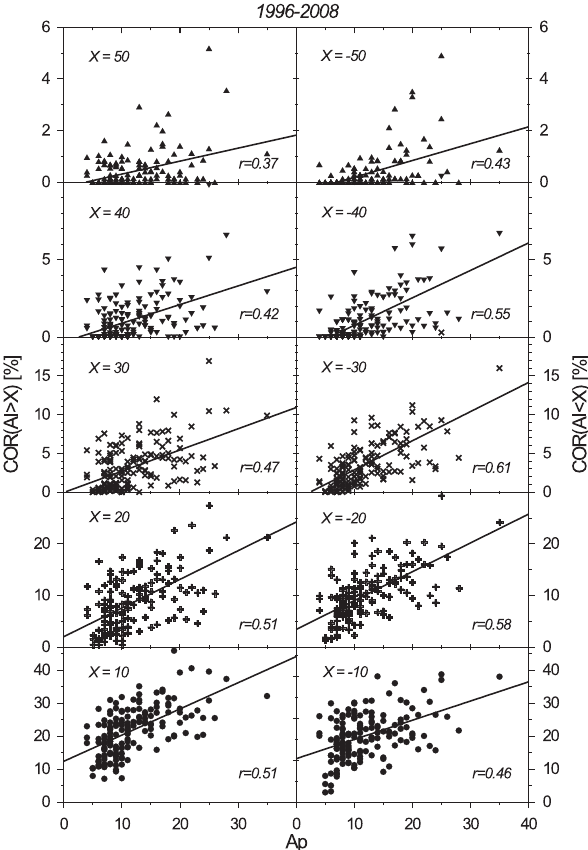
Fig. 14. Dependence of monthly cumulative occurrence rates COR for positive AI values (left part) and negative AI values (right part) on geomagnetic activity for different thresholds X. The black lines are simple regression lines whereas the included values are partial correlation coefficients r=r(COR(AI > X), Ap.F107) for positive AI or r = r (COR(AI < X), Ap.F107) for negative AI values.